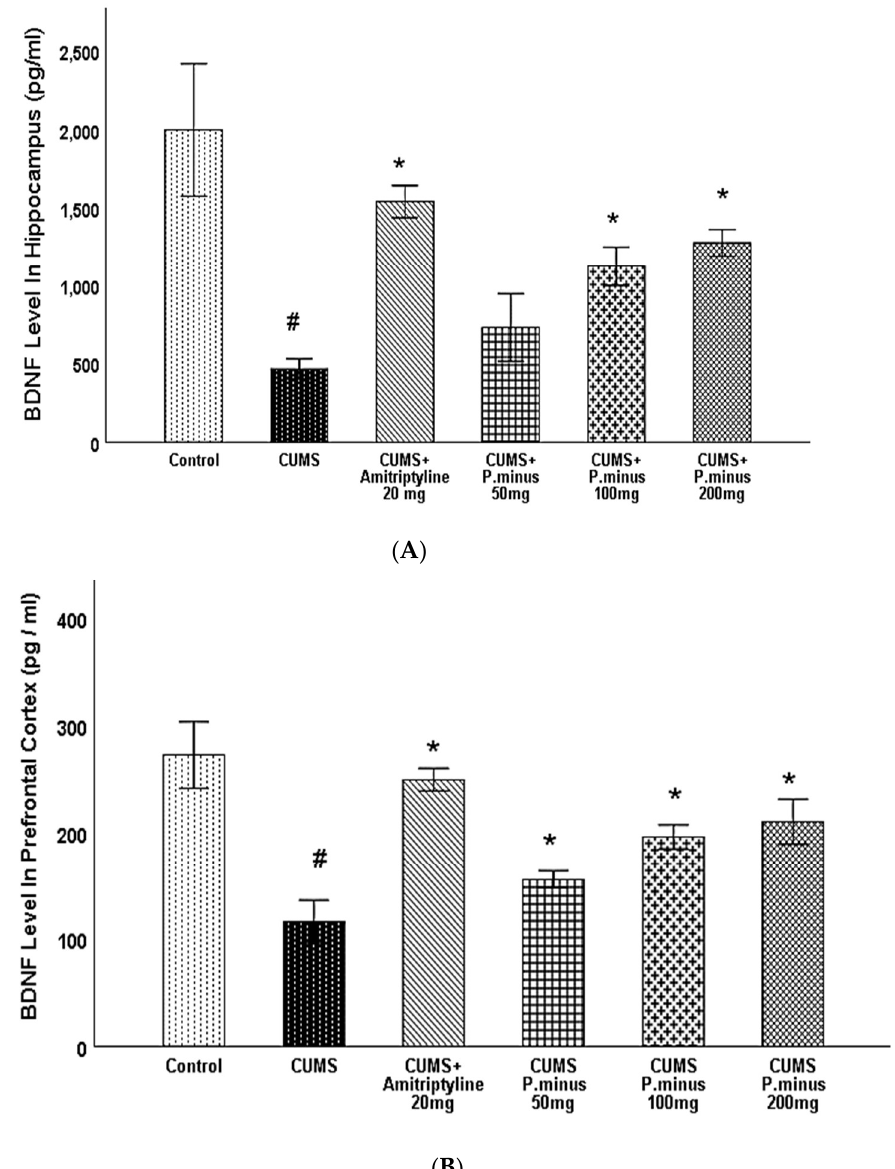
Figure 8. Effects of P. minus aqueous extract on BDNF level in CUMS induced depressive mice. (A) BDNF level in Hippocampus(pg/mL) (B) BDNF level in Prefrontal cortex (pg/mL). # ( p < 0.05), vs. Control group; * ( p < 0.05), vs. CUMS group, ( n = 6).